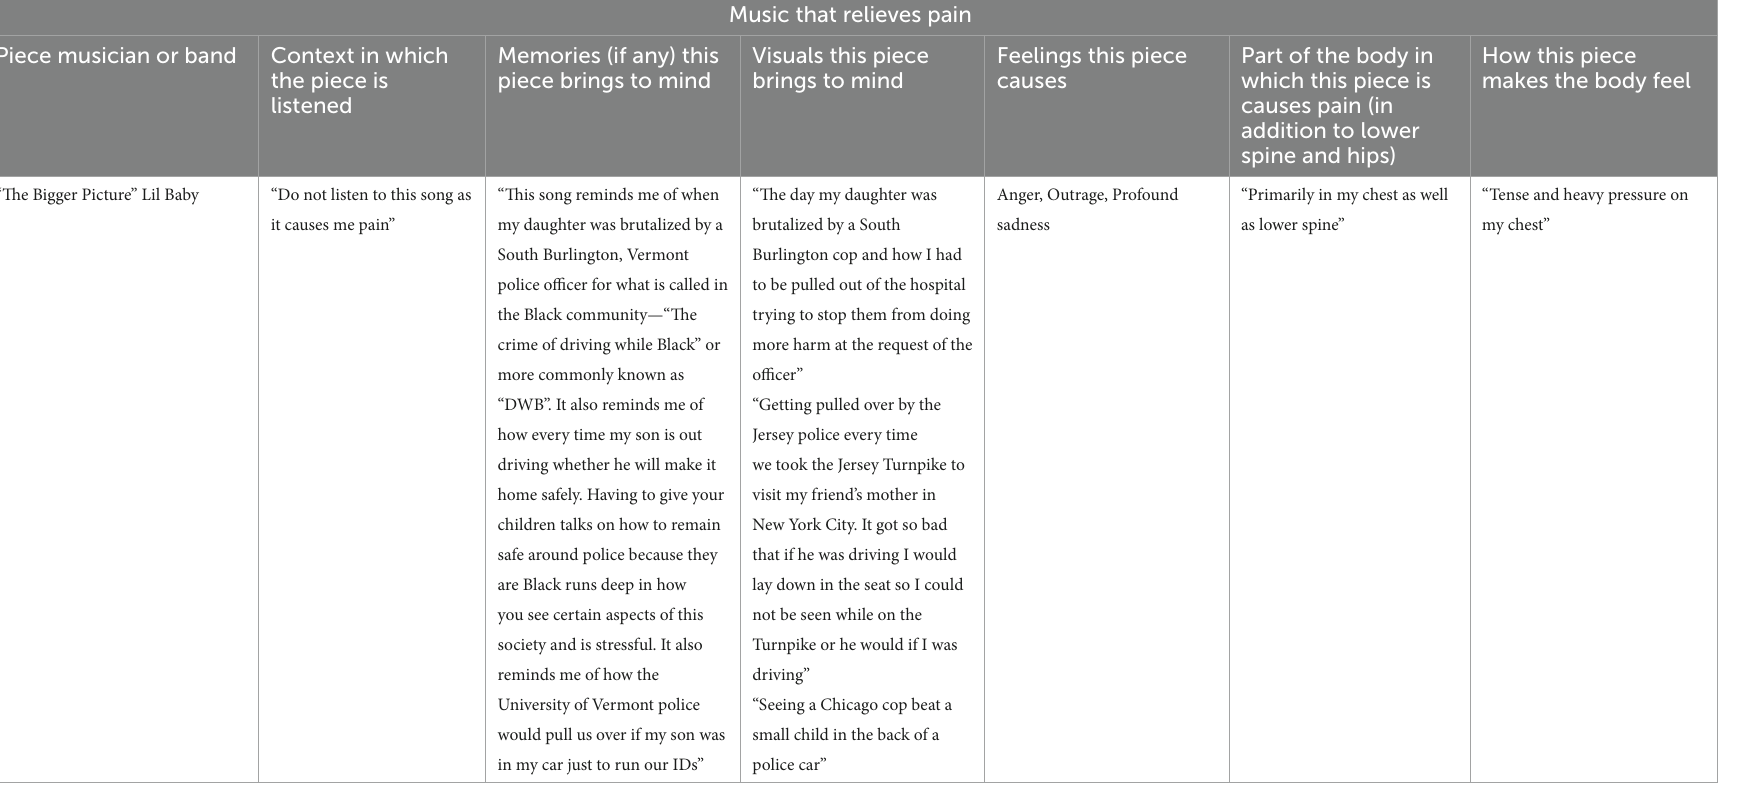
TABLE 2 List of musical pieces that most cause pain to the participant and associated experiences. Piece musician or band